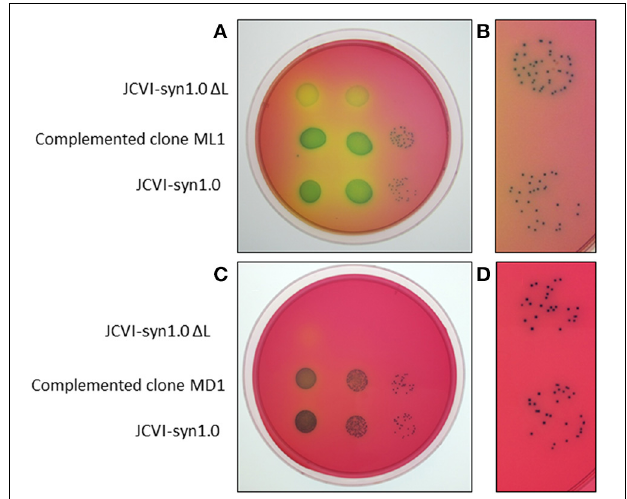
FIGURE 6 | Comparison of a rescued JCVI-syn1.0 (cid:2) L clone with the positive- and negative-control strains for a clone (ML1) obtained using the marker-less approach (A,B) and for a clone (MD1) obtained using the marker-driven approach (C,D). (B) and (D) are magnified views of colonies in (A) and (C) , respectively, showing rescued mutant (top) and wild-type JCVI-syn1.0 (bottom)